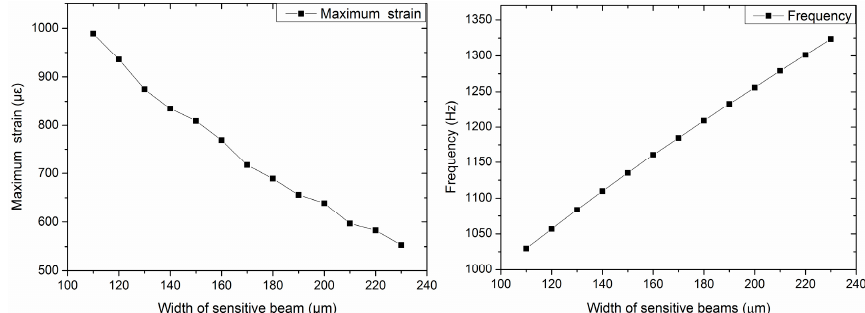
Figure 4. Maximum strain and frequency with different widths of sensitive beams (length is 1200 µ m; thickness is 20 µ m).